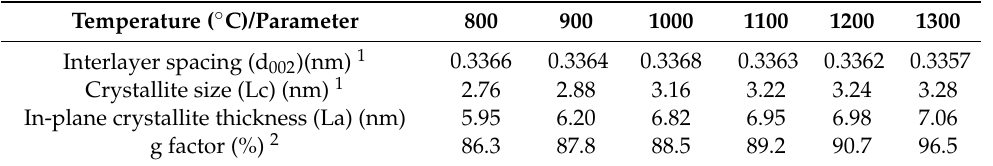
Table 1. Structural properties of catalyst-loaded carbon materials fabricated via microwave-assisted catalytic graphitization at different temperatures.